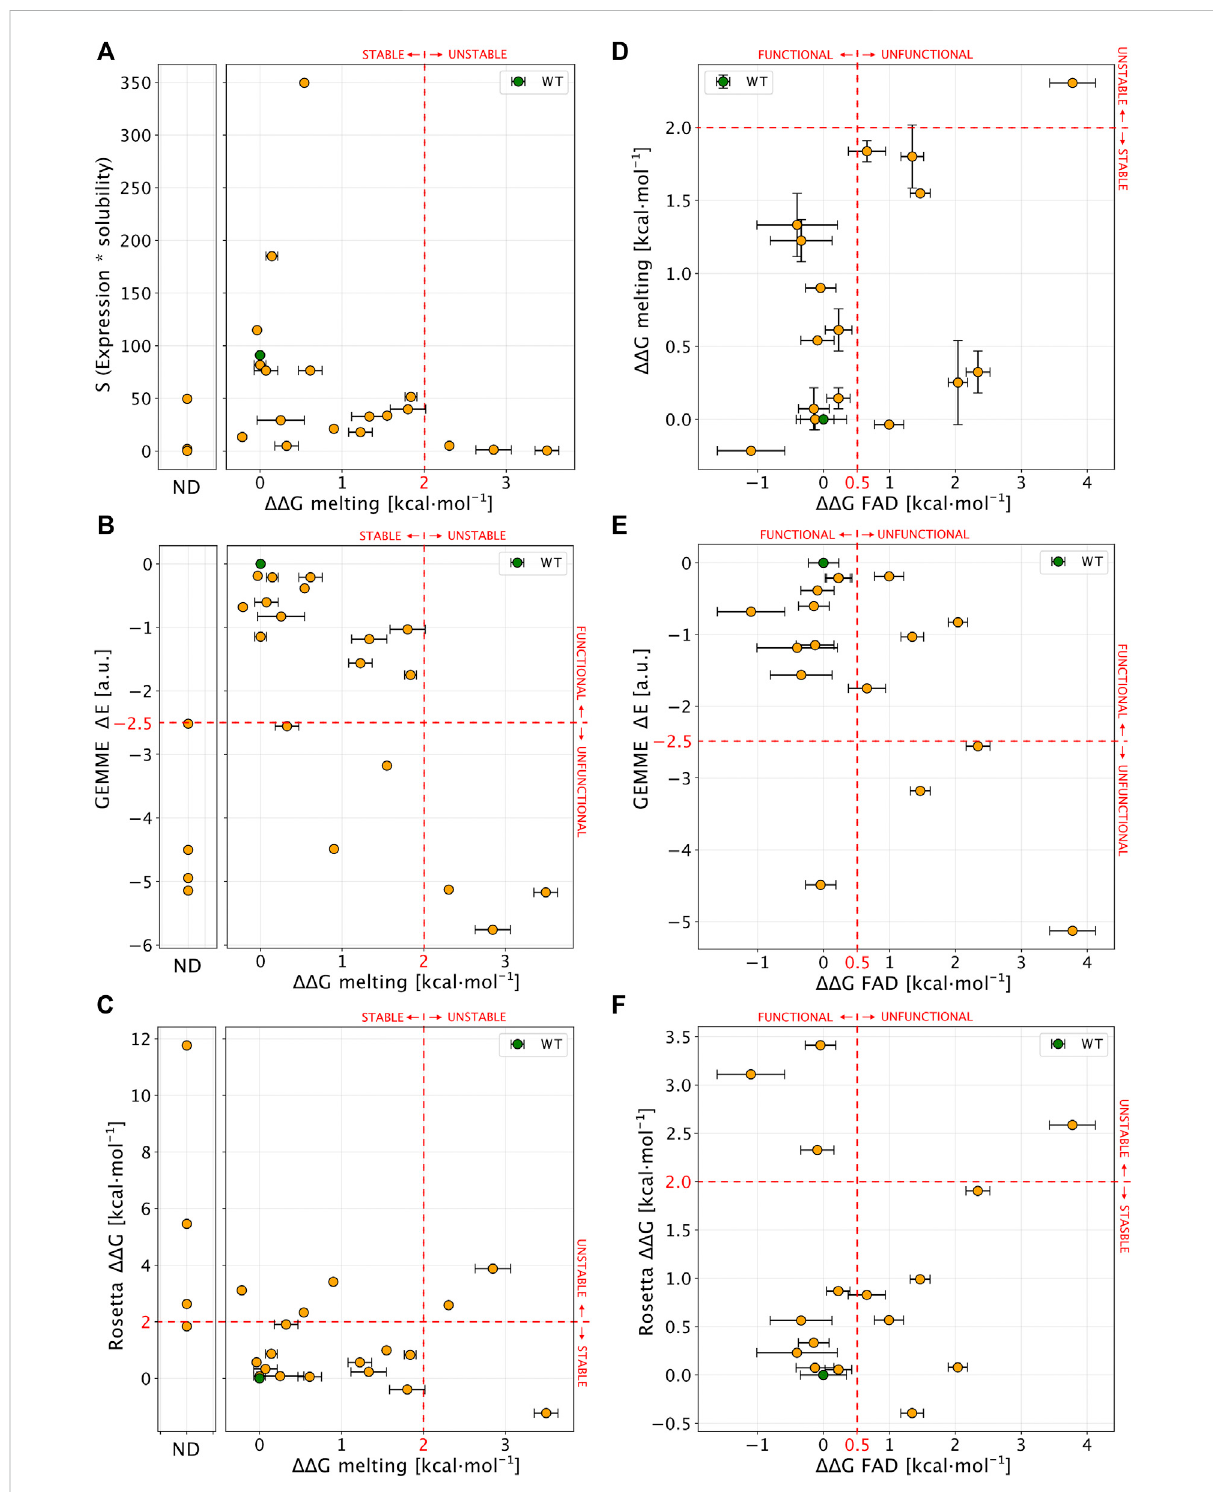
FIGURE 8 Comparison of experimental results with computational scores. (A) Scatter plot of ΔΔ G melting ( x -axis) and S values (expression *solubility). Not- determined variants (ND) in thermal stability experiment are reported in a separate plot. (B,C) show a comparison between ΔΔ G melting and computationalpredictors. (D) Correlation between ΔΔ G melting and ΔΔ G FAD for NQO1 variants detected inboth the experiments. (E,F) Comparison of ΔΔ G FAD with the computational results. Red lines, if present, show the boundary of experimental and computational classes for each comparison. In each panel errors are reported as a black bar on every single variant, if